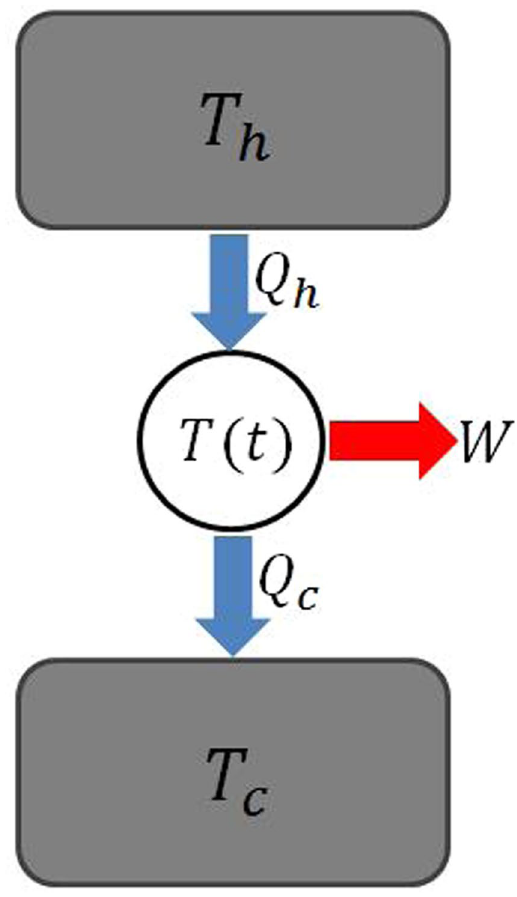
Figure 1. Graphic sketch of a two-heat-source